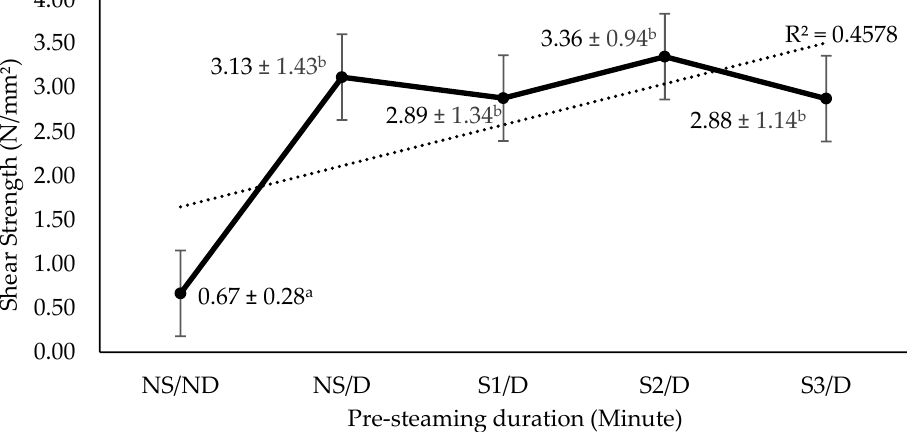
Figure 8. Mean and standard deviation with letters (a, b) indicating significant different ( p ≤ 0.05) for shear strength of glue-laminated timber manufactured from densified Paraserianthes falcataria